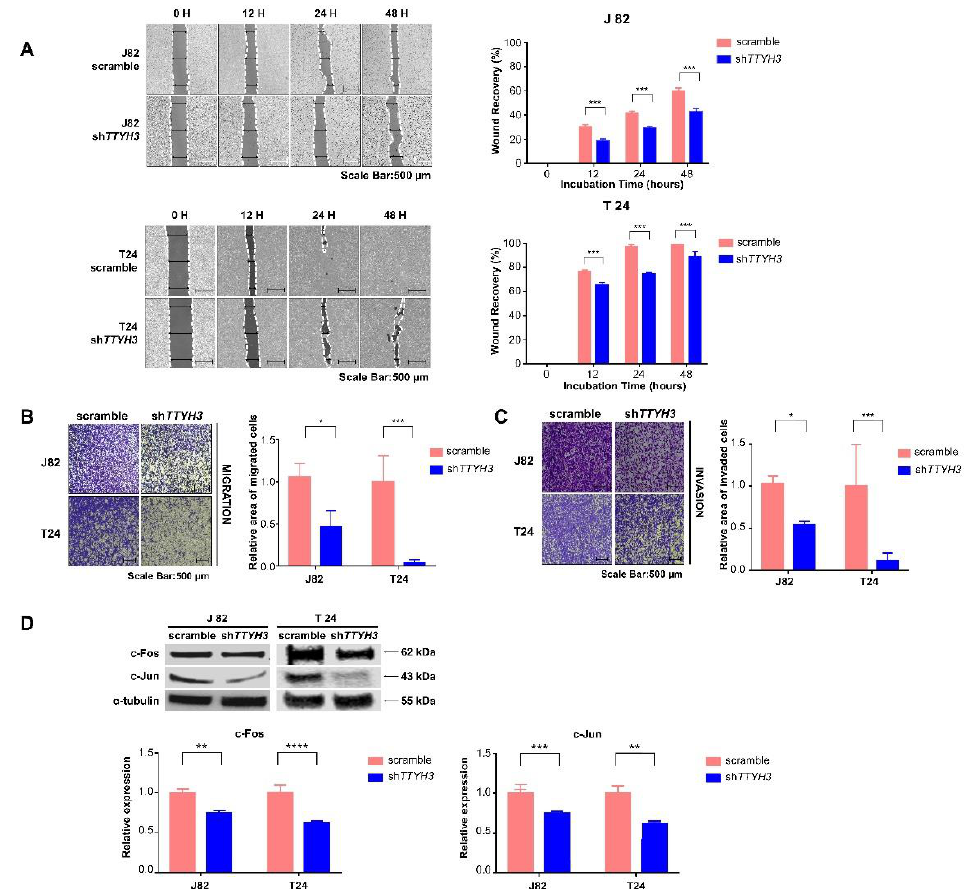
Figure 4. Decreased migration and invasion of TTYH3 knockdown bladder cancer cells. ( A ) Cell mobility measured by a wound healing assay. The uncovered areas in the wound healing assays were quantified as a percentage of the original wound area. The area was measured using T-Scratch. Scale bar denotes 500 µ m. ( B , C ) The effect of TTYH3 knockdown on cell migration and invasion determined by transwell migration assay and basement membrane extract cell invasion assay. Quantifications of migrating or invading cells of each cell line are shown as proportions of their vector controls. Scale bar denotes 500 µ m. ( D ) Western blot analysis of c-Fos and c-Jun proteins in TTYH3-knockdown bladder cancer cell lines. α -tubulin expression was used as the control. Bar graphs show the statistical analysis of three independent experiments. All the statistical analyses were performed with two-way ANOVA; * p ≤ 0.05, ** p ≤ 0.01, *** p ≤ 0.001, and **** p ≤ 0.0001.